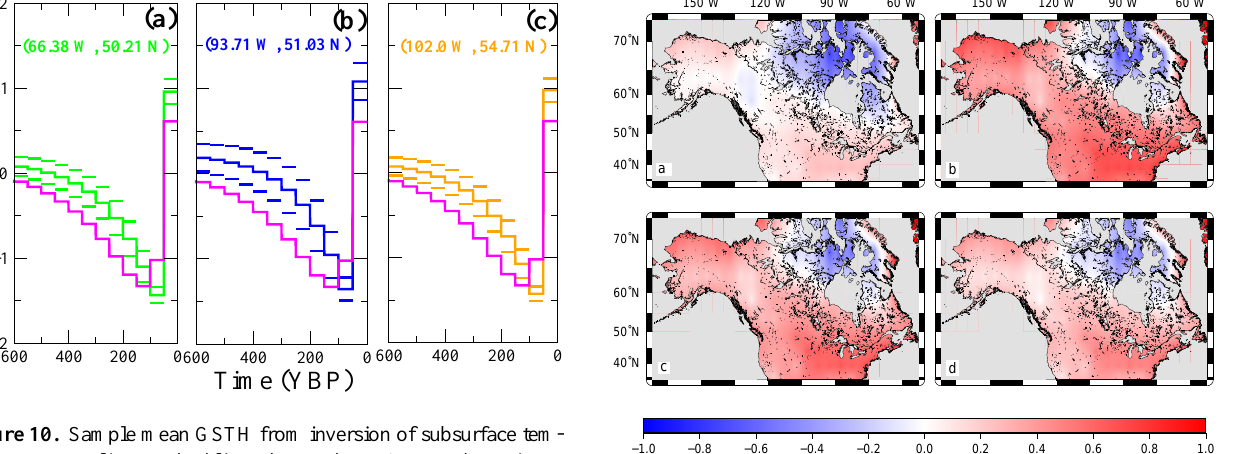
Figure 10. Sample mean GSTH from inversion of subsurface tem- Fig.10. SamplemeanGSTHfrominversionofsubsurfacetemperatureanomalies. Dashedlinesdenotethe75% confidenceintervals. Pinklinesdenotethe”true”GSTHobtainedusingthetheoreticalfunctionofFigure3. perature anomalies. Dashed lines denote the 75% confidence inter- vals. Pink lines denote the “true” GSTH obtained using the theoret- butionoftheresultingdeviationsofestimatedlastmillenniumhistoriesatdifferenttimeintervalsfor ical function of Fig. 3. Fig. 11. Spatial distribution of differences in estimated GSTH with and without the influence of the LGC; each grid point. Note again that we have assumed a constant last millennium history at all locations 380 in the domain, thus the resulting spatial variations are due entirely to differences in the LGC basal histories locally.